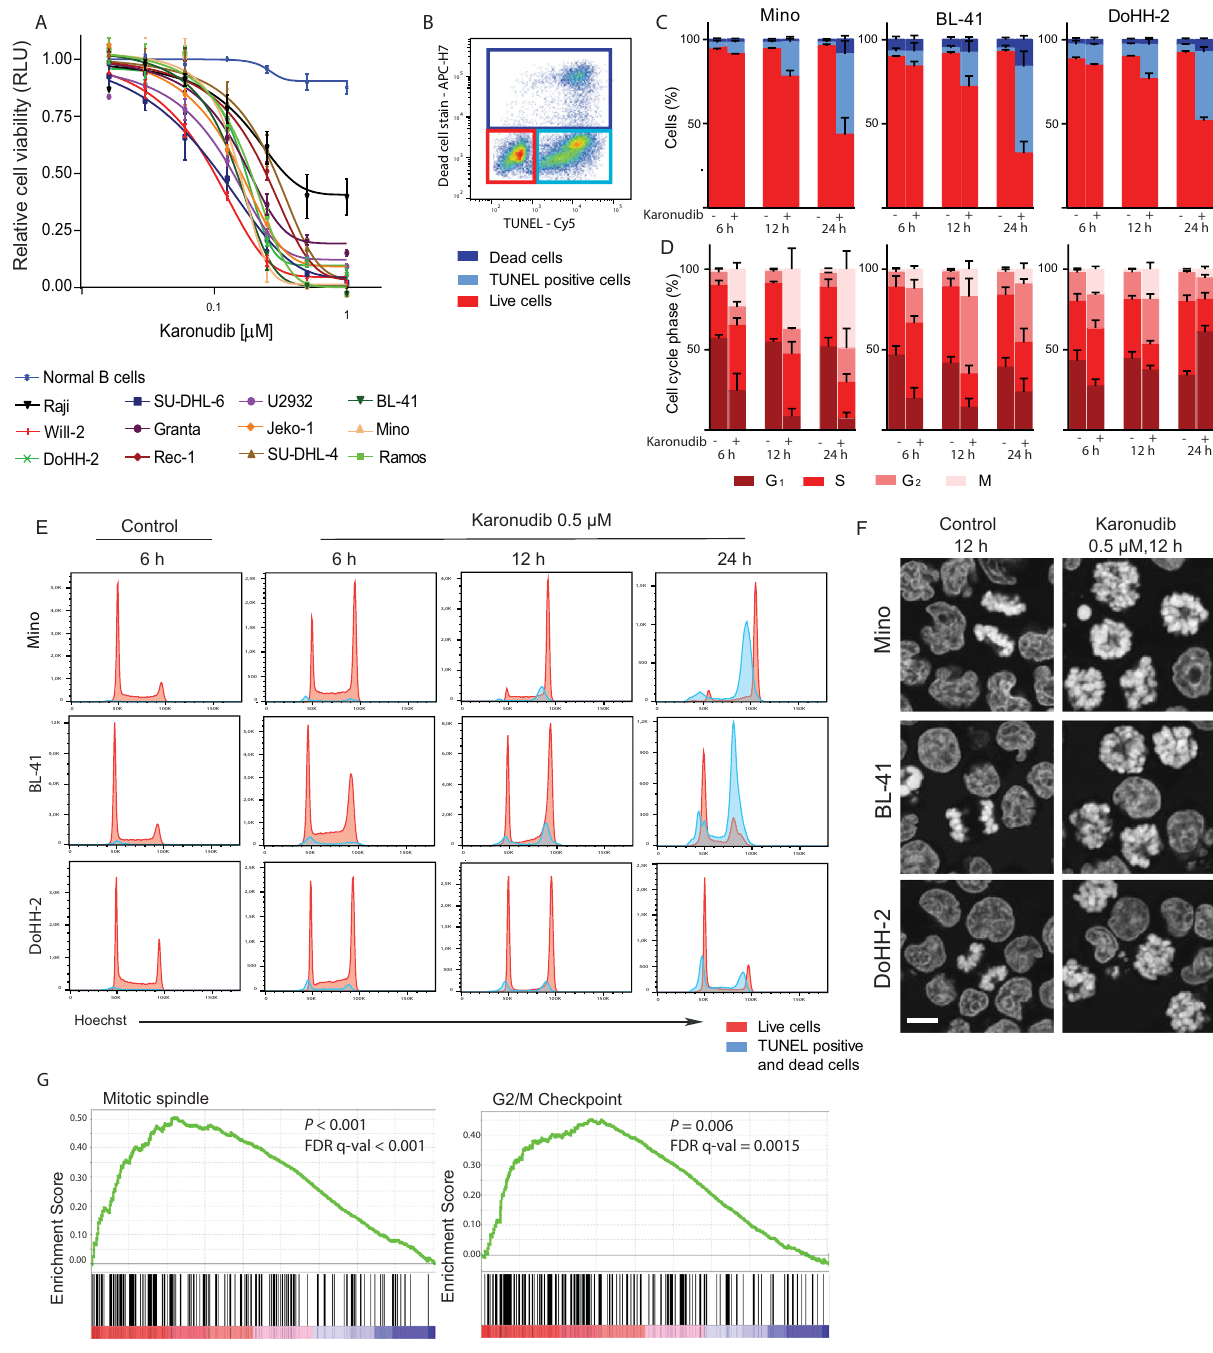
Figure 2. Karonudib induces apoptosis after metaphase arrest in lymphoma cell lines, without affecting healthy B cells. ( A ) Cell viability was measured by CellTiterGlo and normalized to untreated samples (karonudib, 0.0125–1 µM, 72 h, n = 3). ( B ) Gating strategy to identify apoptotic cells is shown for Mino cells (karonudib, 0.5 µM, 24 h): TUNEL + , light blue gate;, dead cells, dark blue gate; and live cells in red gate, and ( C ) the frequencies of these populations in Mino, BL-41 and DoHH-2 (karonudib, 0.5 µM, n = 3). ( D ) Cell cycle analyses of the live cells (from C ). ( E ) Histograms representing live (red) and dead/apoptotic cells (blue) show G 2 accumulation and M-arrest after karonudib treatment. DoHH-2 also show a G 1 arrest at 24 h and cells entering apoptosis from G 1 -arrest. ( F ) Microscopy of Hoechst stained cells from the same experiment in ( B – E ) (12 h with or without 0.5 µM karonudib, 63×/1.4 objective, bar = 10 µm). An error in the spindle assembly is clearly visible in cells treated with karonudib (images captured randomly), whereas images of successful chromosome segregation in control cells were chosen to illustrate the difference. ( G ) GSEA of BL-41 and Mino cells (karonudib, 0.5 µM, 12 h), identified Mitotic spindle and G 2 /M-Checkpoint as significant altered gene sets ( P < 0.001 and P = 0.006) (GSEA software